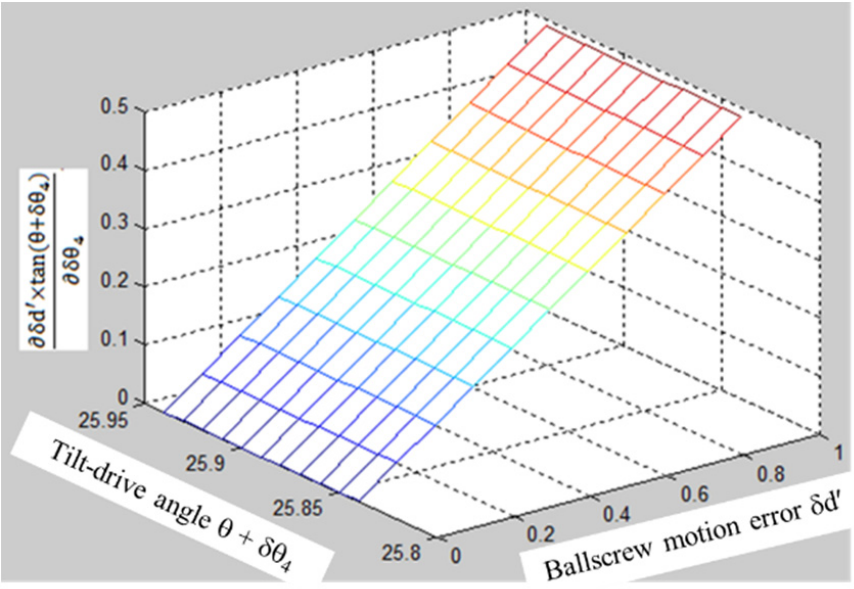
Figure 10. Relationship between the ballscrew motion error δ d ′ and parameter sensitivity.